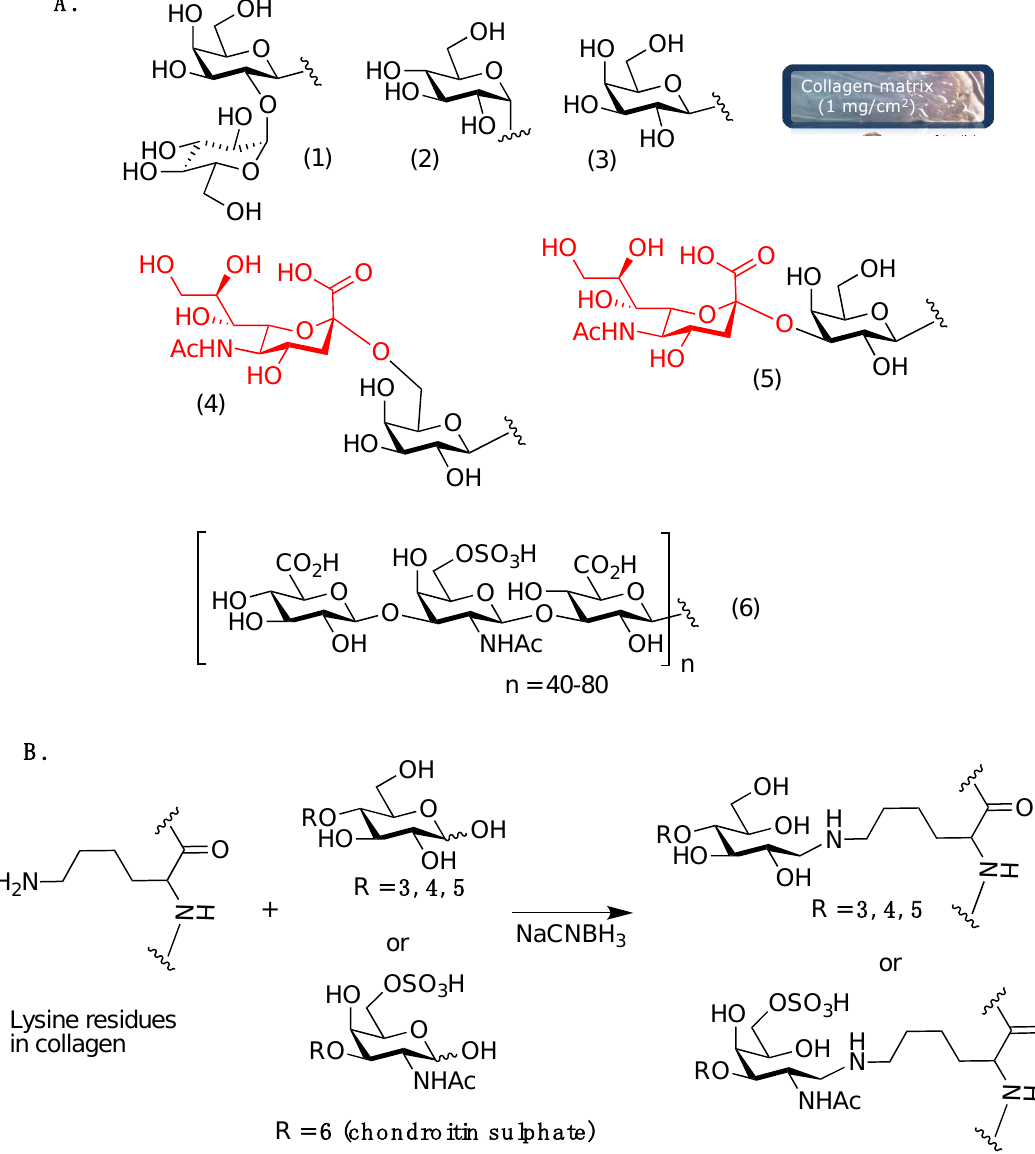
Figure 1. ( A ) Carbohydrate epitopes grafted to collagen matrices: (1) the native collagen glycosylation motif, (2) α -glucosides, (3) β -galactosides, (4) sialyl α -(2 → 6)-galactoside, (5) sialyl α -(2 → 3)-galactoside, (6) chondroitin sulphate. ( B ) Grafting chemistry for collagen matrix functionalization.